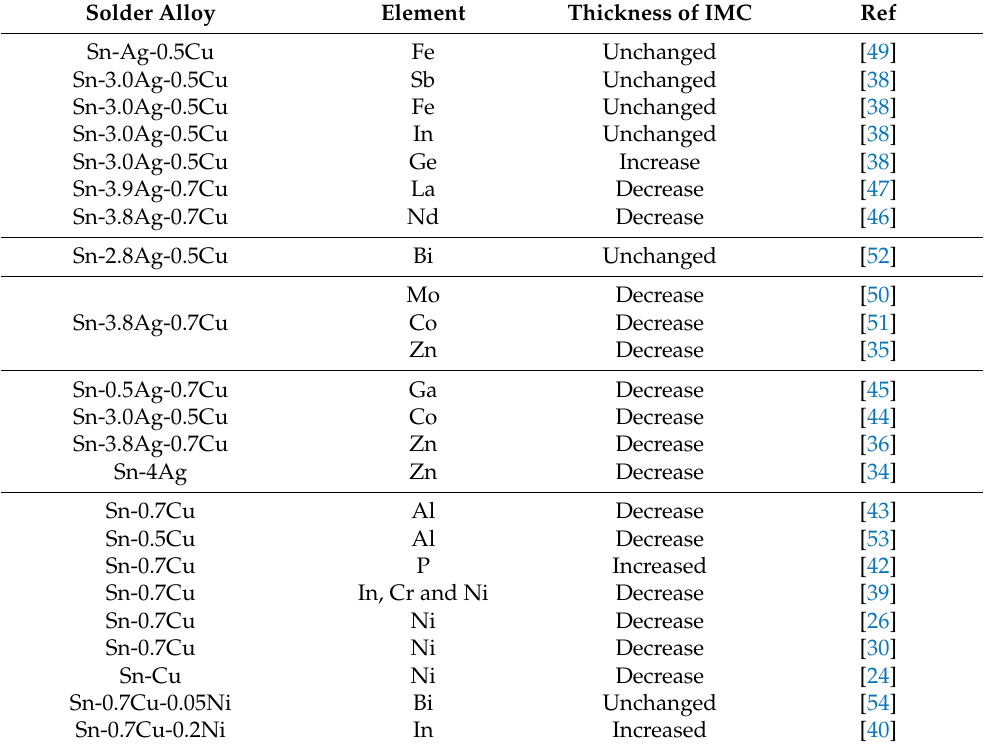
Table 1. Influence of minor alloying elements to the IMC thickness in lead-free solder